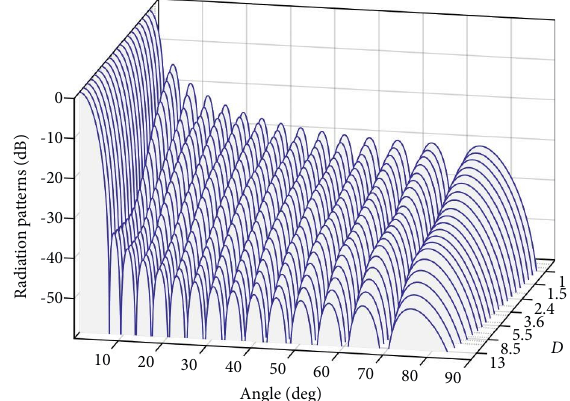
Figure 6: Radiation patterns of pencil beam arrays with 30 ele- ments and beamwidth of 12 ° , obtained by minimization of SLP and DRR constrained to various values between D � 1 and D � 12.6.